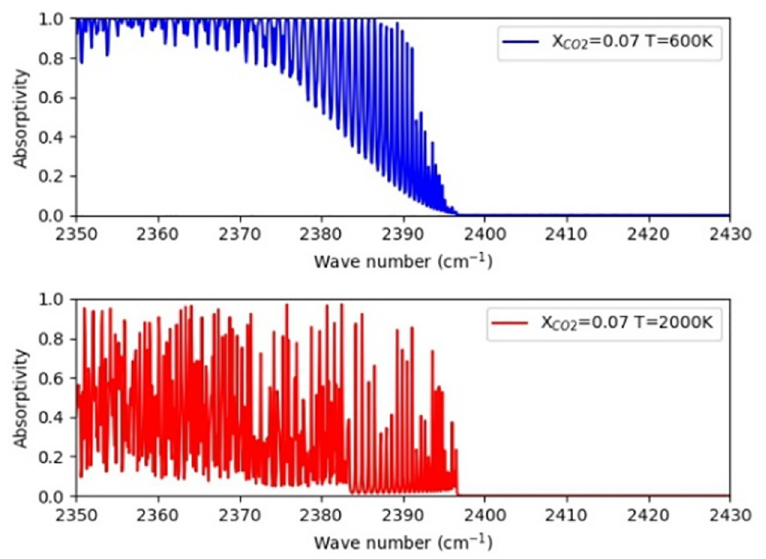
Fig 2. The boundary cases of spectra at temperatures of 600 K (top) and 2000 K